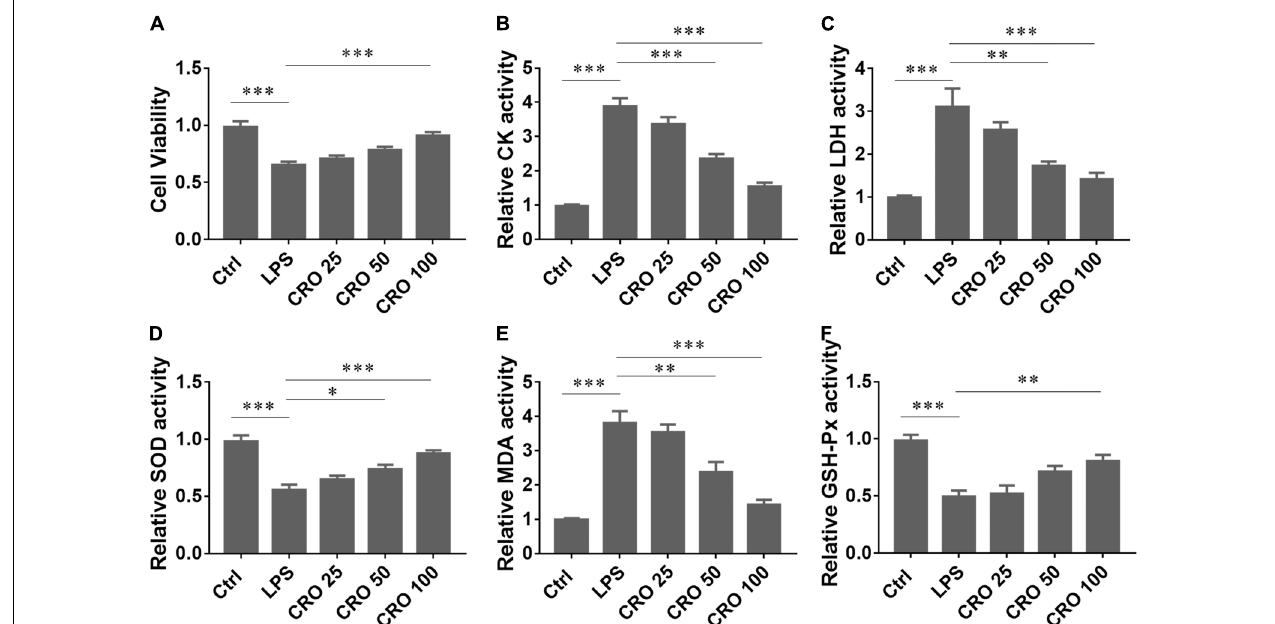
FIGURE 1 | Effect of CRO on cytotoxic indices in LPS-induced cardiac sepsis. (A) Effect of CRO on cell viability of LPS-induced H9c2 cells. Data ( n = 6) are presented as the mean ± SEM, *** p < 0.001. (B,C) Effect of CRO on CK and LDH in LPS-induced H9c2 cells. Data ( n = 6) are presented as the mean ±